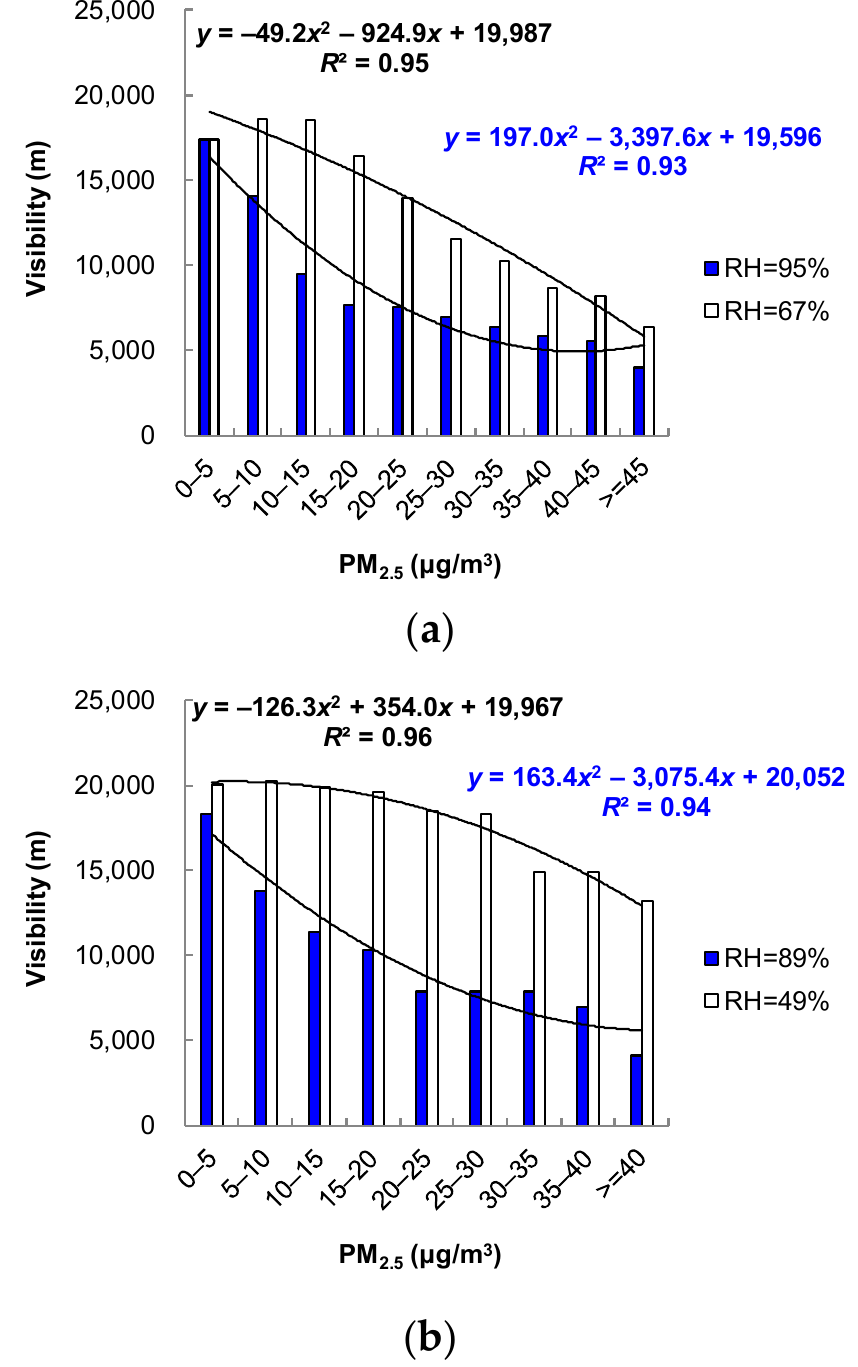
Figure 2. Negative relationship between PM 2.5 concentration and visibility during different situations from 2016 to 2019 in the Taipei metropolis: ( a ) synoptic weather pattern type I when 67% ≤ RH ≤ 95%; ( b ) synoptic weather pattern type III when 49% ≤ RH ≤ 89%. Fisher’s least significant difference test was used to assess whether the differences in the values for the distinct groups were statistically significant [44]. This method was used to determine whether visibility and other parameters varied among the groups in the